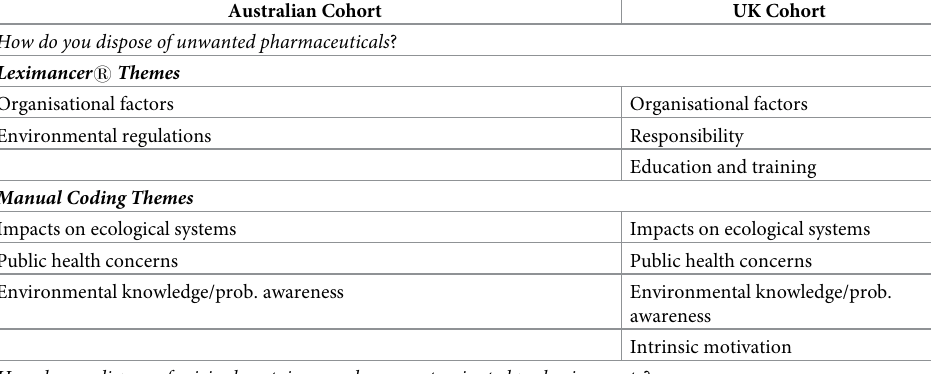
Table 4. Comparison of environmental knowledge between Australian and UK cohorts–knowledge of action